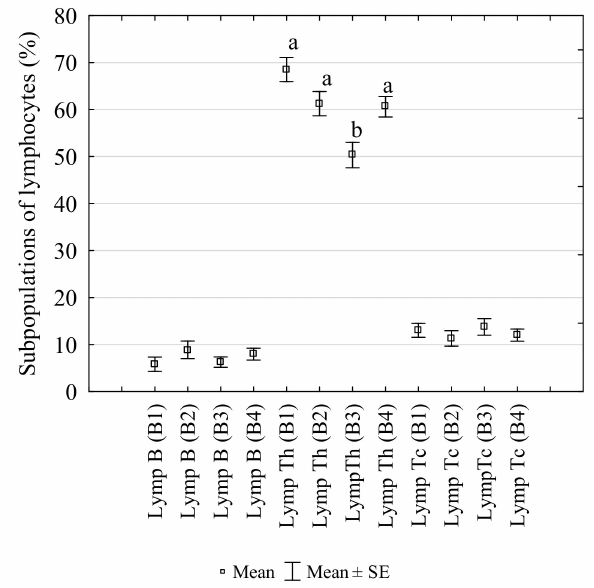
Figure 2. Changes in the percentages of B IgM + cells (Lymp B), T CD3 + CD4 + cells (Lymp Th) and T CD3 + CD8a + cells (Lymp Tc) in the peripheral blood of laying hens infested with Dermanyssus gallinae , controlled with Biobeck PA 910 (AI silicon dioxide, Biologische Preparate, Brilon, Germany). (B1–B4: blood sampling dates; a,b: di ff erent letters indicate statistical di ff erences between